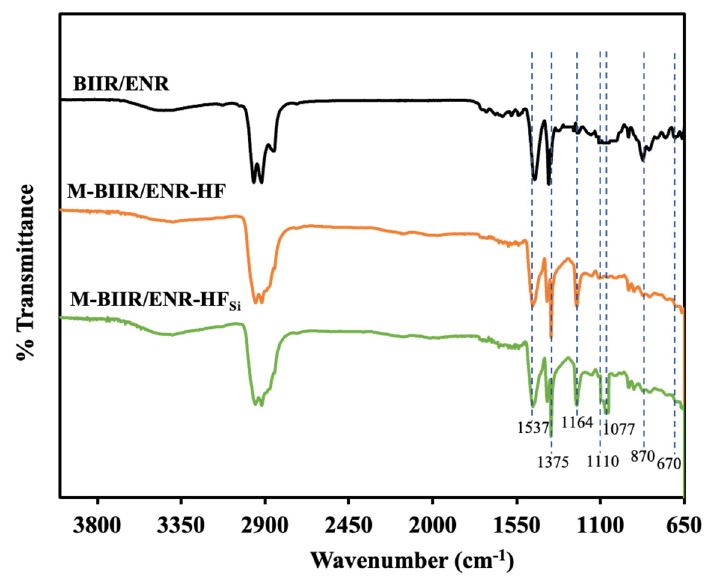
Figure 4. ATR-FTIR of BIIR/ENR of unmodified BIIR and M-BIIR/ENR composites filled with CNT/CB with and without the addition of TESPT. Table 4. Assignments of the peak of infrared spectra in Figure 4.